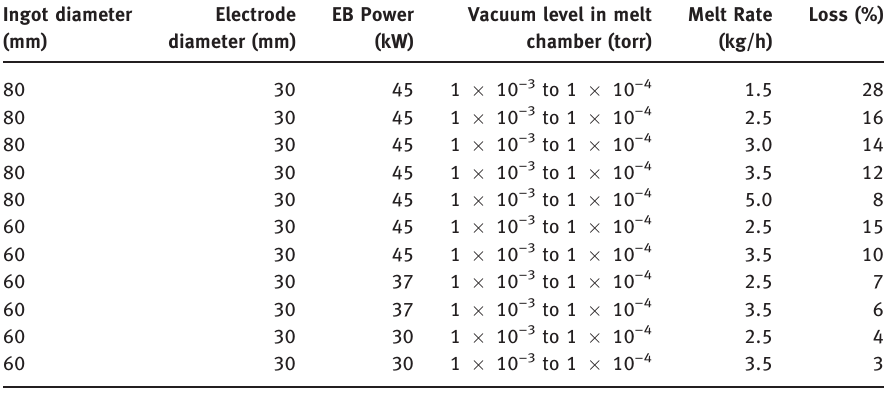
Table 5: Loss of niobium during EB melting. Ingot diameter Electrode